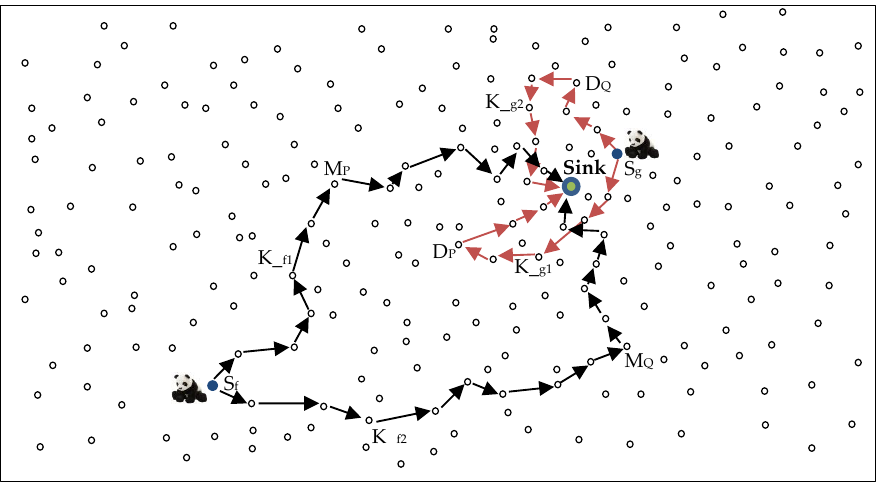
Figure 5. An example of a packet routing strategy using the proposed